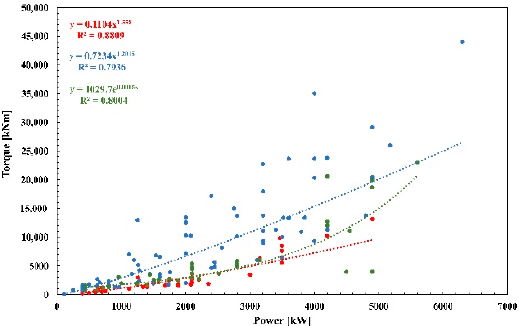
Figure 5. Correlation between the power supplied to the excavation head and the torque. Red: open TBM; blue: single shield TBM; green: double shield TBM.